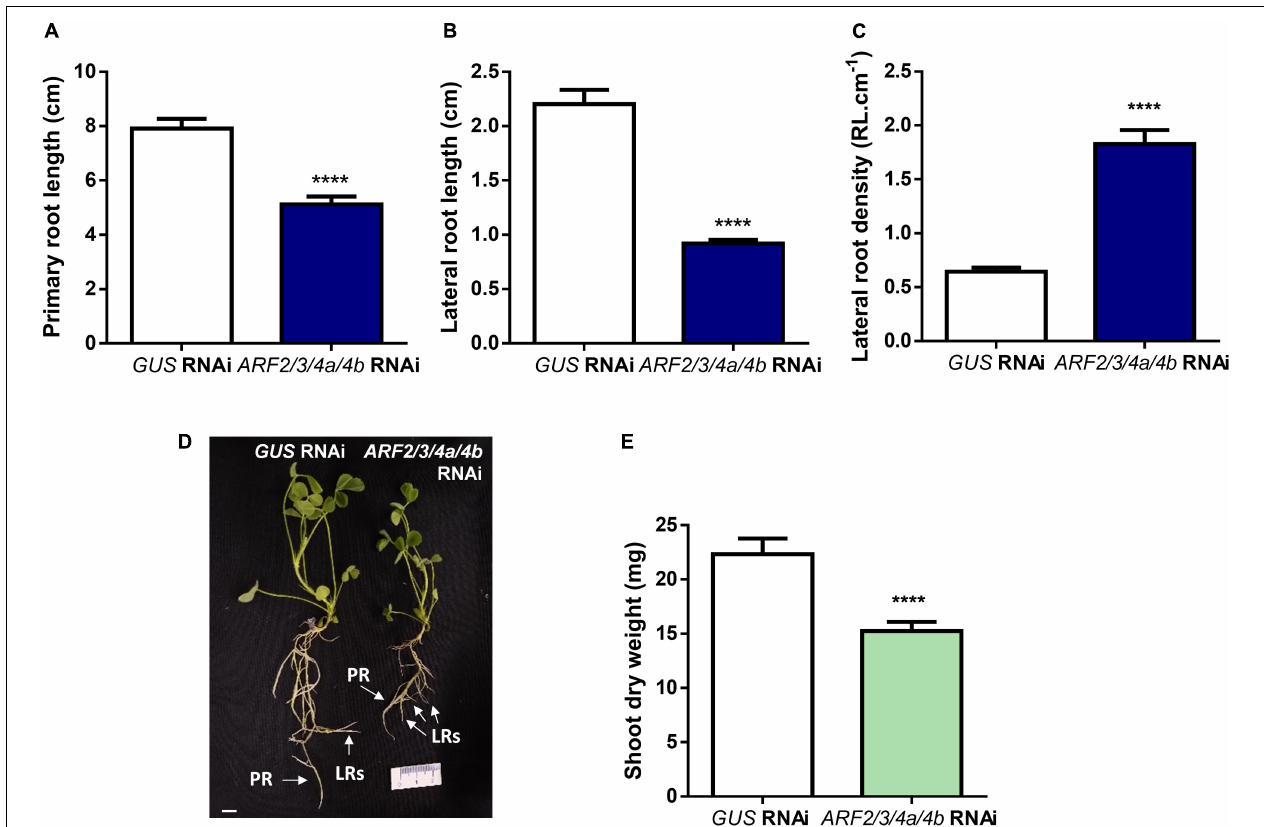
FIGURE 7 | Knockdown of MtARF2, MtARF3, MtARF4a , and MtARF4b altered root architecture. (A–C) Length of independent primary transgenic roots (A) and lateral root (B) and density of lateral roots (C) were measured in GUS and ARF2/3/4a/b RNAi roots at 15 days after transplantation to square petri dishes slanted agar-Fahraeus medium supplemented with 8 mM KNO 3 . Error bars represent mean ± SE of three independent biological replicates with more than 20 roots in each experiment. Four asterisks indicate statistically significant differences between GUS RNAi and ARF2/3/4a/4b RNAi roots in an unpaired two-tailed Student’s t test with a p value ≤ 0.0001. (D) Image of GUS and ARF2/3/4a/4b RNAi composite plants illustrating the shorter primary and lateral roots observed in ARF2/3/4a/4b RNAi roots. Each root that emerged directly from the sectioned site of the non-transgenic roots inoculated with A. rhizogenes was considered independent transgenic primary root (PR), whereas first-order roots that emerged from each independent transgenic primary root were considered lateral roots (LRs) in the hairy root system. Scale bar: 1 cm. (E) Shoot dry weight measured in GUS and ARF2/3/4a/4b RNAi composite plants at 15 days after transplantation to square petri dishes slanted agar-Fahraeus medium supplemented with 8 mM KNO 3 . Error bars represent mean ± SE of three independent biological replicates with more than 10 composite plants in each experiment. Four asterisks indicate statistically significant differences between GUS and ARF2/3/4a/4b RNAi composite plants in an unpaired two-tailed Student’s t test with a p value ≤